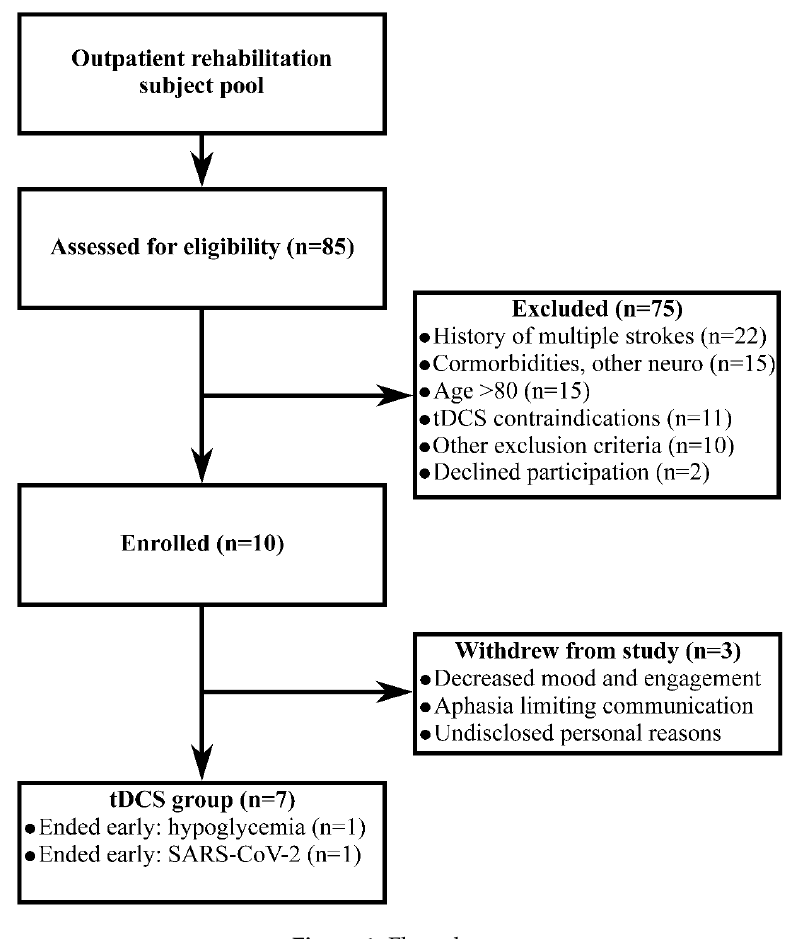
Figure 1. Flow chart.